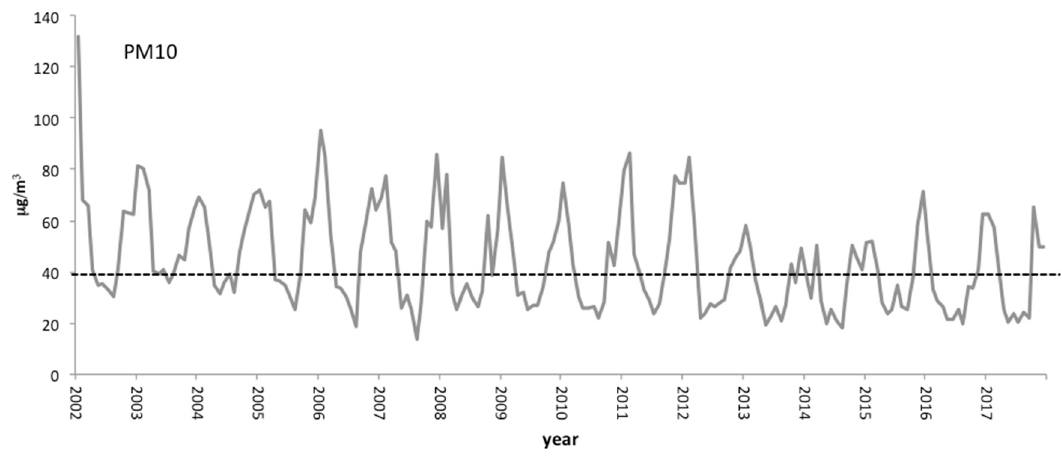
Figure 4. Particulate matter (PM) 10 concentrations trend registered for Milan monitoring sites (data from ARPA Lombardia); average annual limit (according to D. Lgs. 155/2010) has been reported (dotted line).